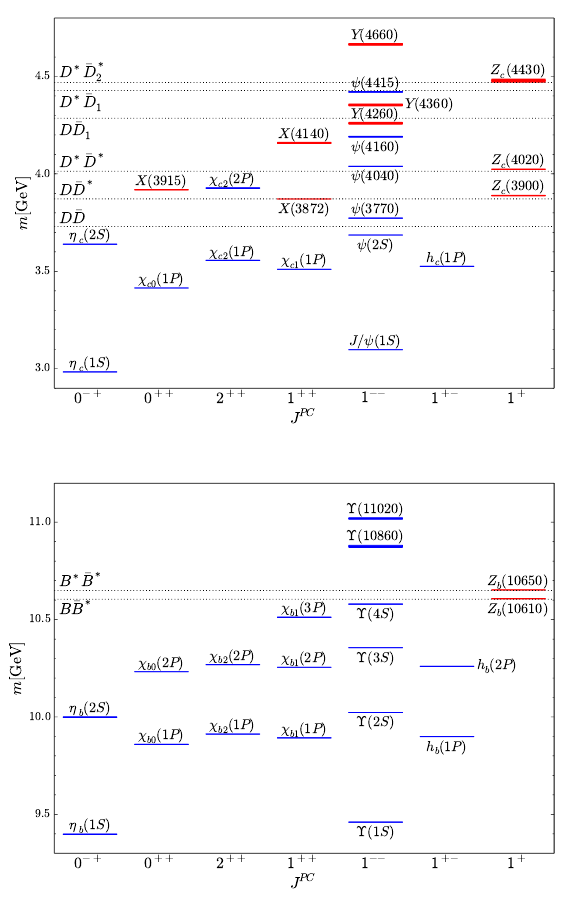
Figure 2. The measured hadronic states in the spectrum of bottomonium. States which can(not) be described by the quark model are marked with